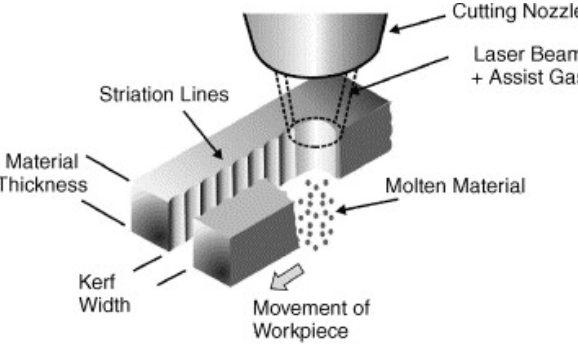
Figure 4. A schematic diagram for striation formation during the laser cutting process [35].